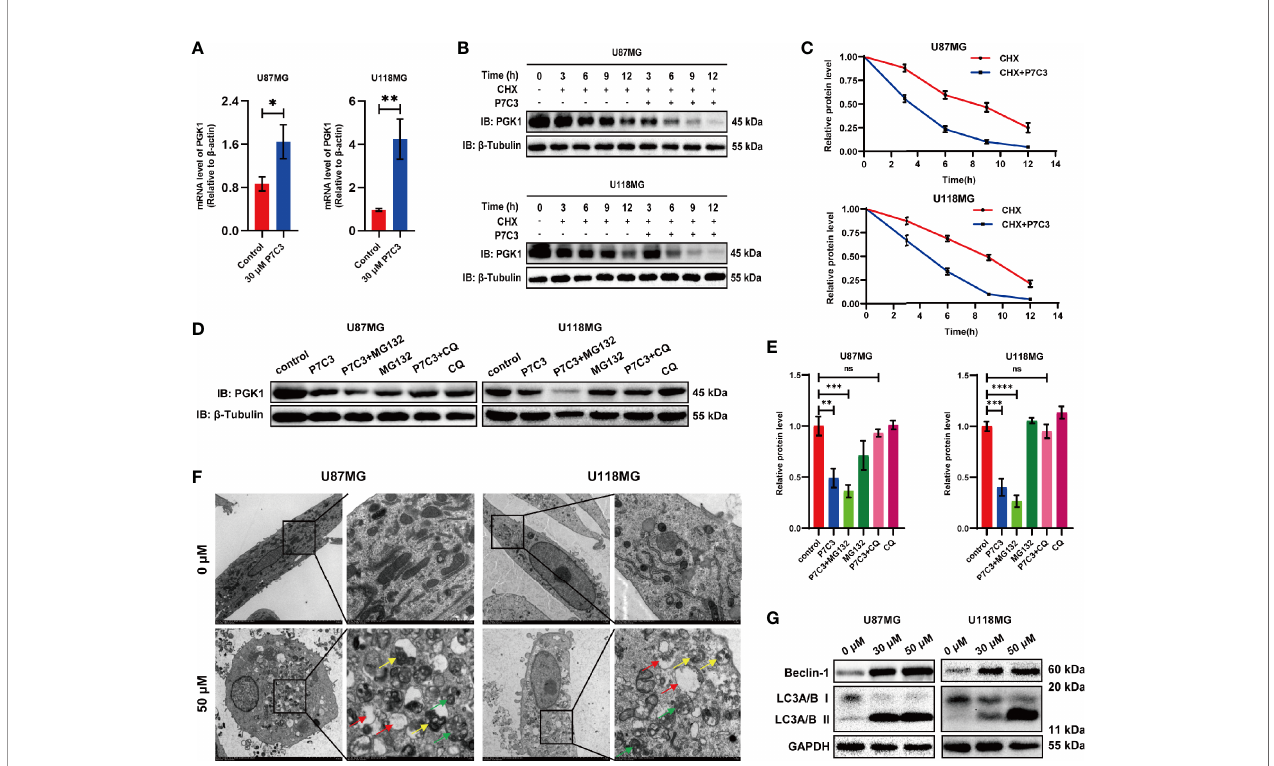
FIGURE 5 | P7C3 accelerates PGK1 protein degradation. (A) PGK1 mRNA level was measured by RT-PCR. P7C3 upregulates the PGK1 mRNA levels in U87MG and U118MG cells (n = 3). (B) Time-course assay of P7C3 effects on PGK1 degradation. U87MG and U118MG cells were treated by CHX (100 ug/mL) with or without P7C3 (50 m M) for 24 h, and then PGK1 protein levels were detected by western blotting. (C) Protein level curve for PGK1 based on time-course analysis of U87MG and U118MG cells (n = 3). (D) Western blotting of PGK1 protein degradation pathway. MG132 (5 m M) and CQ (20 m M) were used to treat cells for 6 h, followed by P7C3 treatment for another 18 h, and the protein level of PGK1 was detected by western blotting. (E) The statistical analysis of the quantized protein levels of PGK1 in U87MG and U118MG cells (n = 3). (F) Transmission electron microscopy assay after glioma cells were treated with P7C3 for 24 hours. Autophagosomes, autolysosomes, and phagophores are indicated by yellow, green, and red arrows (scale bar: original mage, 5 m m; Zoom image, 1 m m). (G) Western blotting for two key autophagy-associated proteins Beclin-1, and LC3A/B, after U87MG and U118MG cells were treated with 0 m M, 30 m M, and 50 m M P7C3 for 24 h. (Data are expressed as mean ± SD, ns P > 0.05, * P < 0.05, ** P < 0.01, *** P < 0.001, **** P < 0.0001, ns means none signi fi